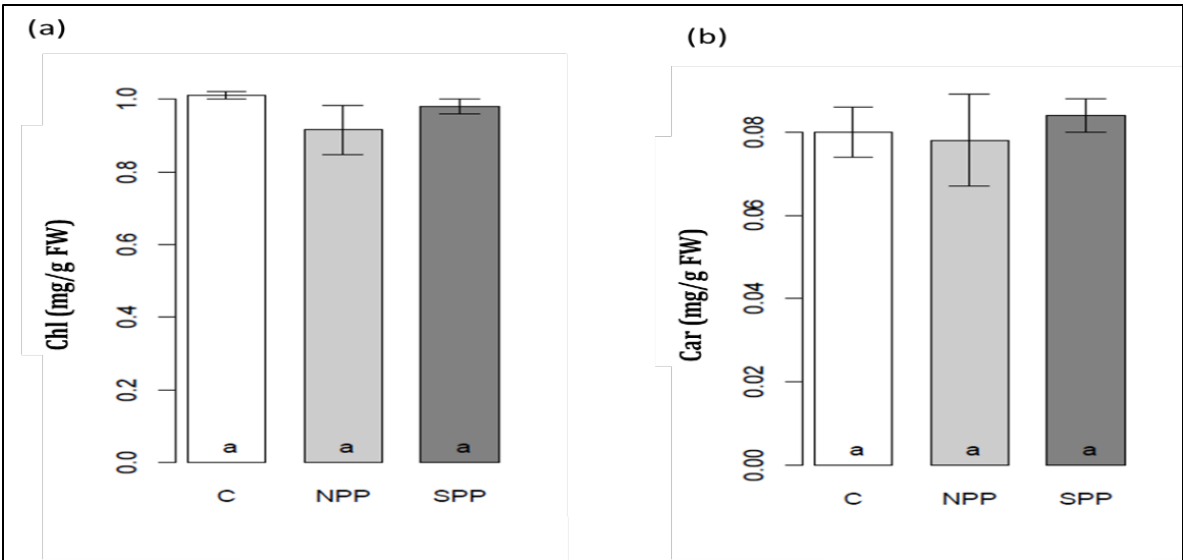
Figure 7. Changes in total chlorophyll content ( a ) and carotenoid content ( b ) of primed and nonprimed olive leaves subjected to subsequent drought. Significant differences between the means (at p < 0.05, according to ANOVA) appear with different letters. Values are means ± standard error ( n = 6), where ‘ n ’ is the number of replicates for each group.